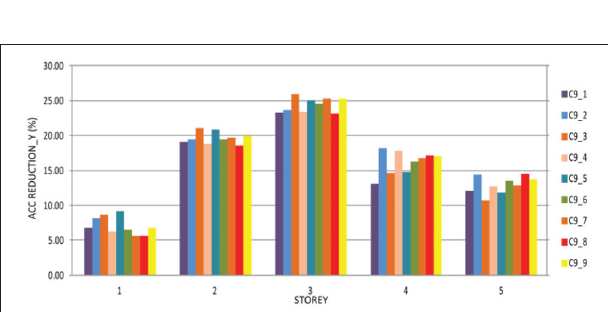
FIGURE 13 | Reduction of the accelerations per story of the structure with the optimal solutions from the ninth cycle compared with the structure without dampers in Y